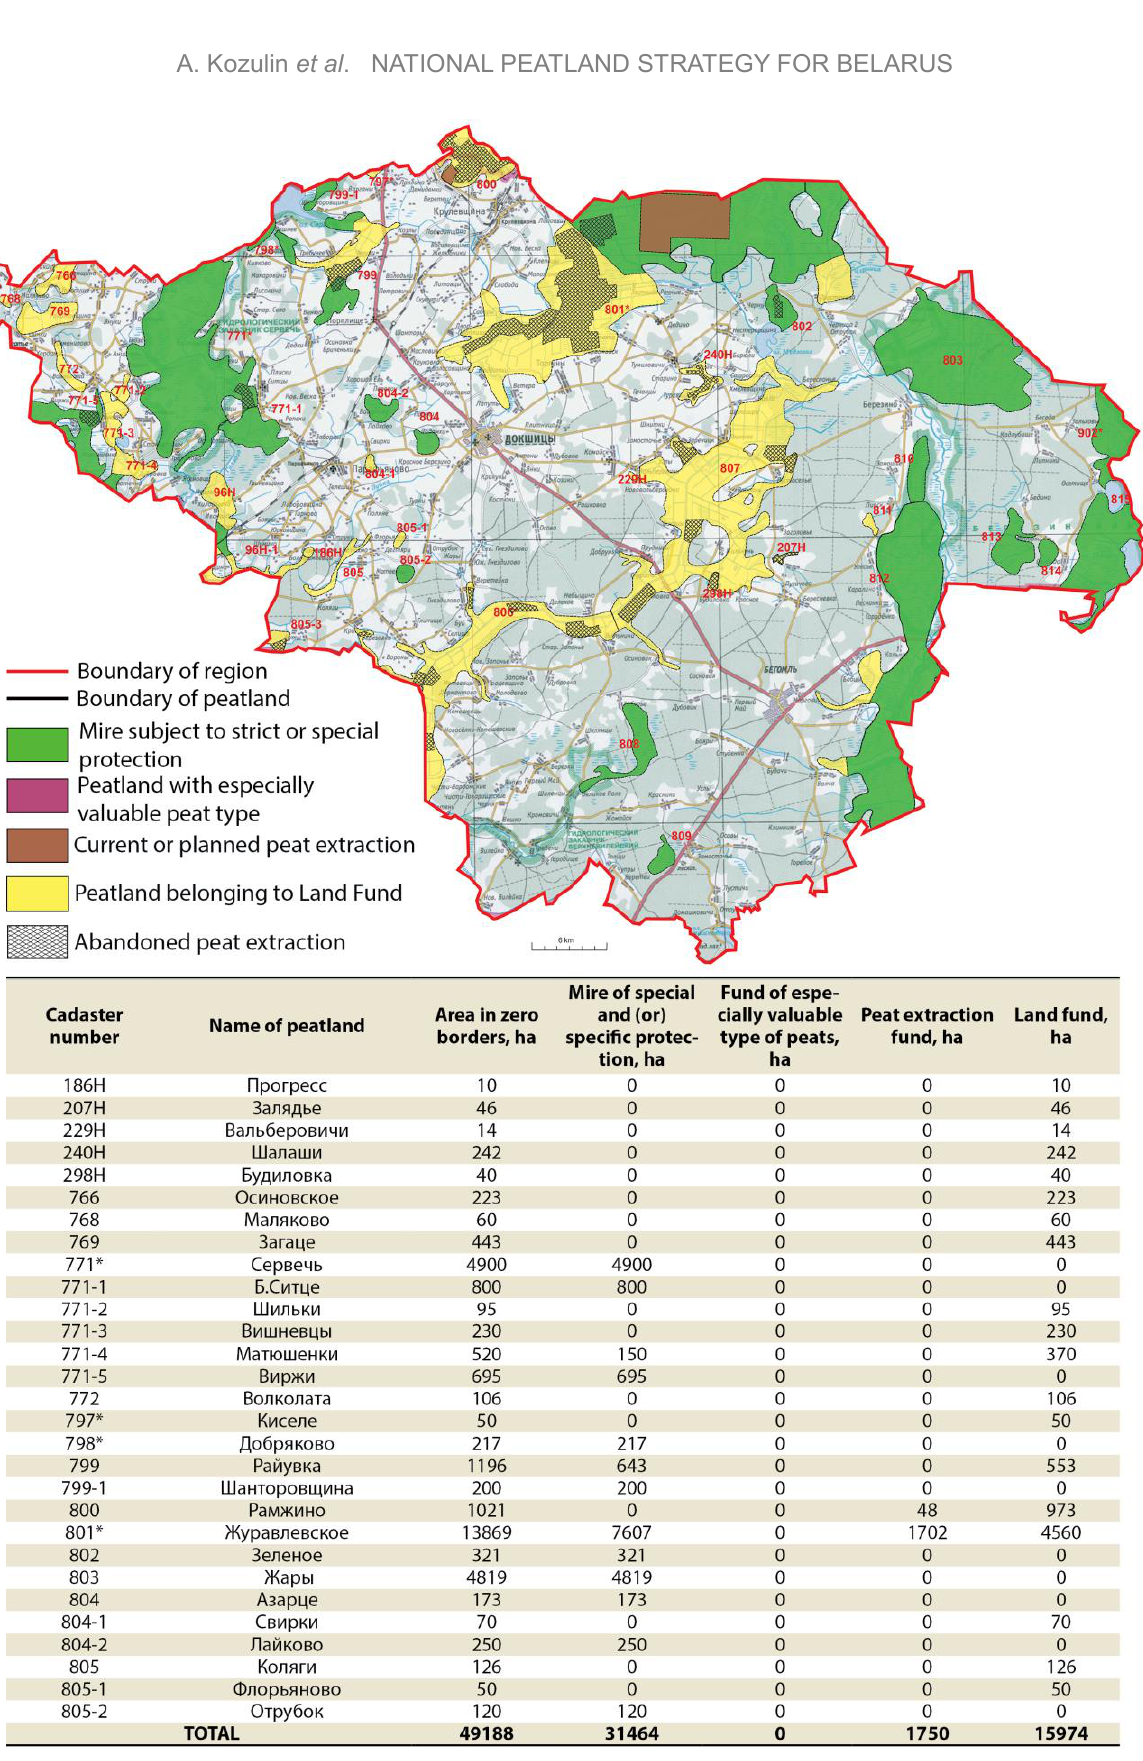
Figure 8. Map showing the distribution of peatlands allocated to each type of use in Dokshitsy district of Vitebsk